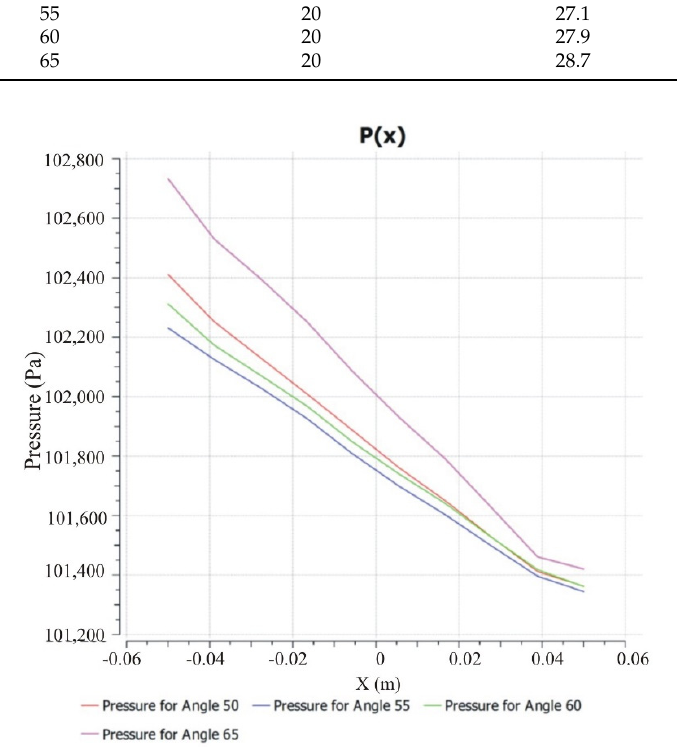
Figure 15. Pressure drop graph: red—angle 50°; blue—angle 55°; green—angle 60°; purple—angle 65°.